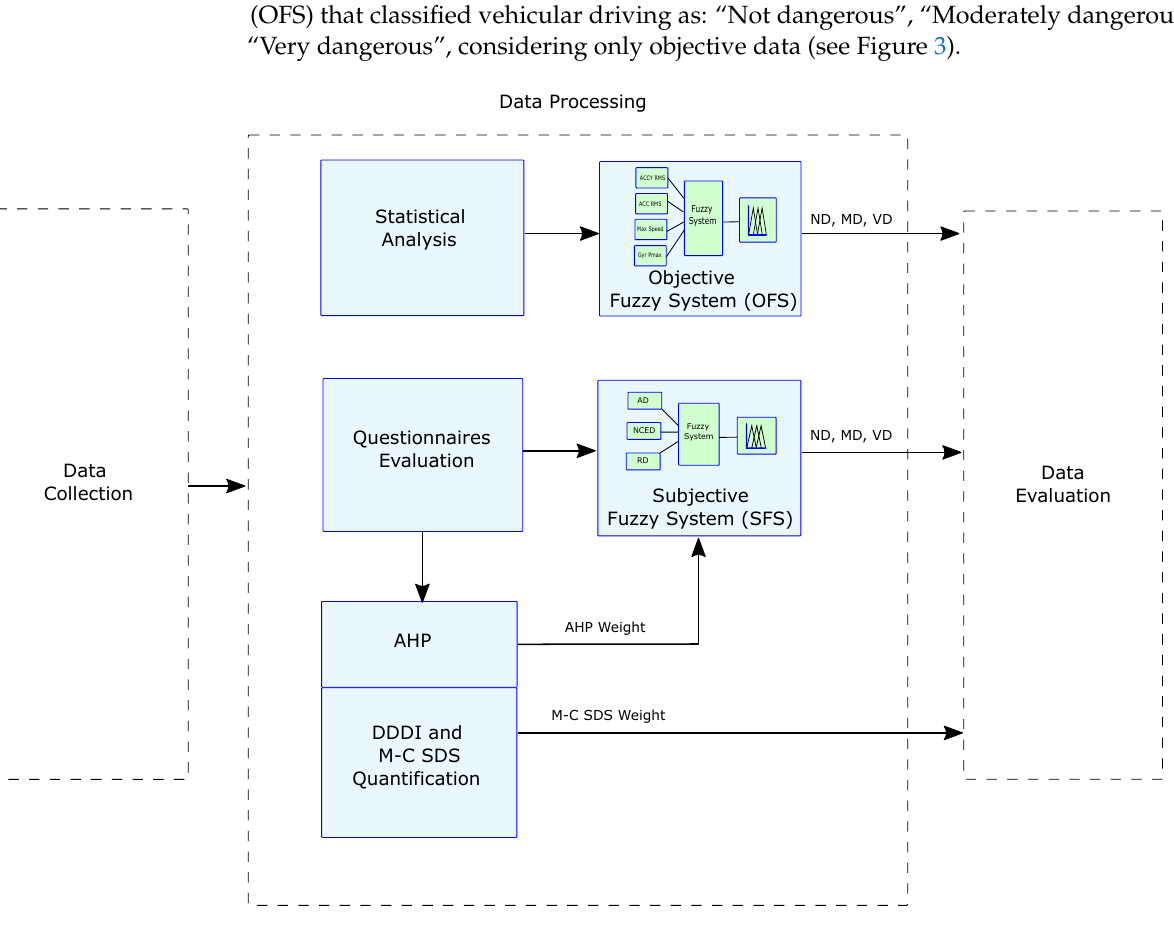
Figure 3. Data processing